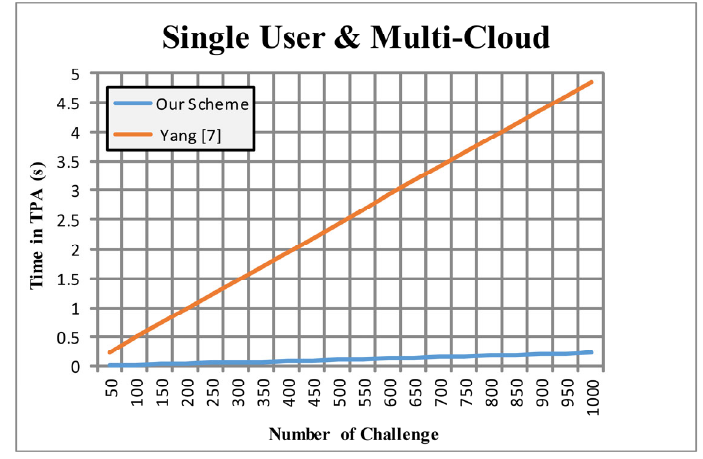
Figure 5. Computation cost on the semi-trust server with a single smart device user and multi-cloud.